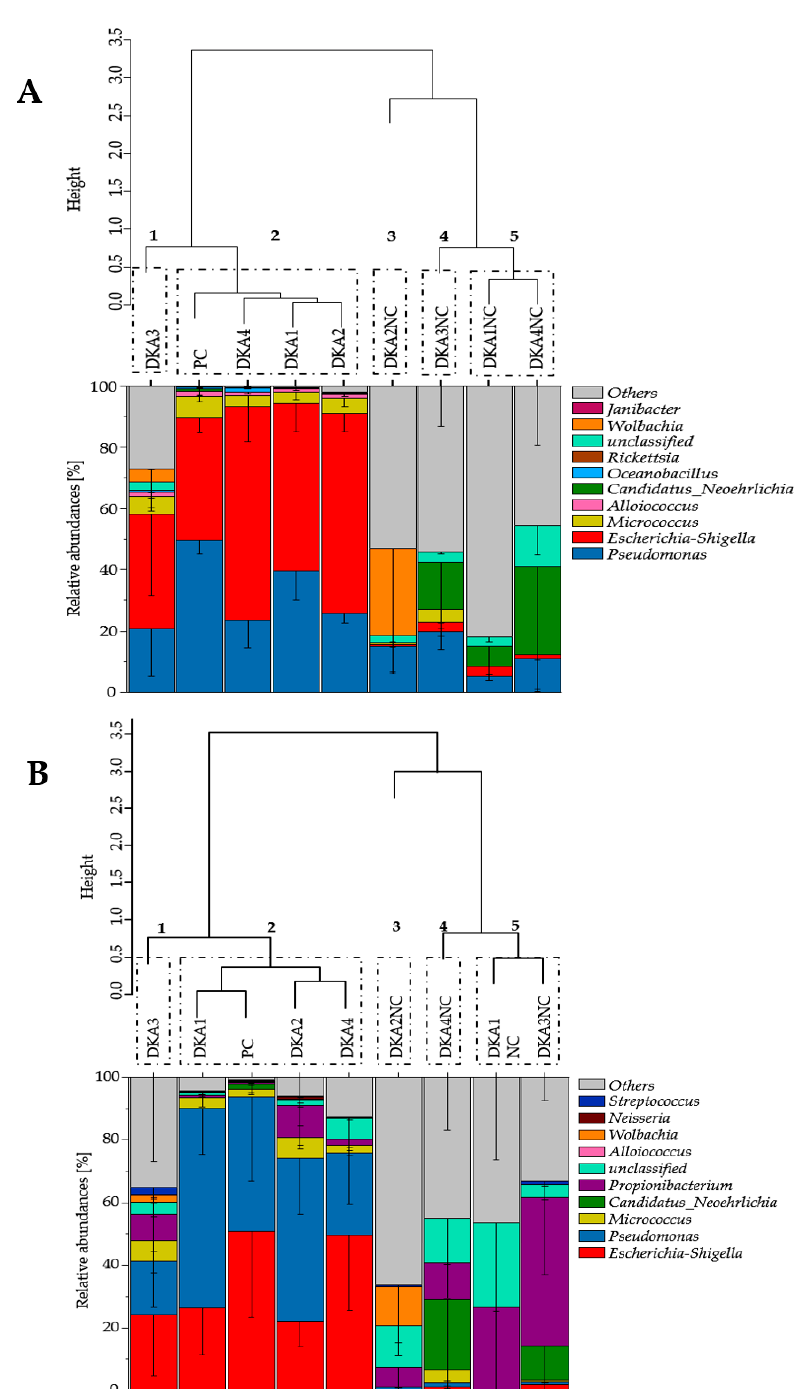
Figure 3. Euclidean distance matrix based on the ward.D2 method (above) and bacterial community composition on genus level (below) for the DNA ( A ) and cDNA samples ( B ) of 70% ethanol (DKA 1), DNA Away (DKA 2), 5% sodium hypochlorite (DKA 3) and RSDL (DKA 4) decontaminated ticks. PC (positive control) without decontamination and NC (negative control) ticks without contamination. For colors and patterns, see figure legend. The bacterial community composition of the ten most abundant genera are denoted and other genera are summarized as “others”, and composition of each sample can be in Supplementary Figure S2. For clusters, a height of 0.5 was chosen, numbered and denoted in dashed boxes. The details of treatments and replicates are summarized in Table 1. Table 4 Relative Operational Taxonomic Unit (OTU) abundances from the tick microbiome assigned to M. luteus , P. fluorescens and E. coli after decontamination treatment with 70% ethanol (DKA 1), DNA